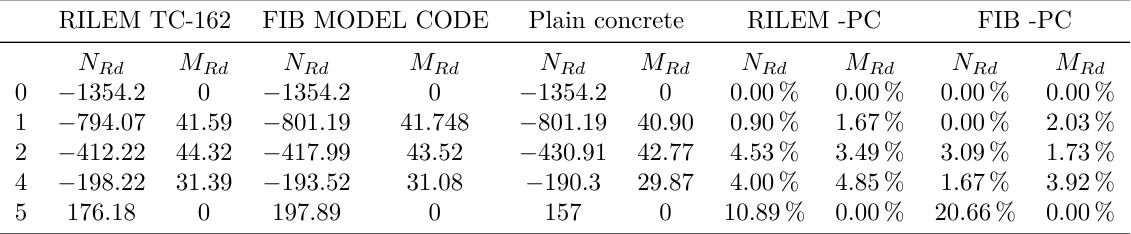
Table 1. Comparison of bending moment and normal forces for various methods of